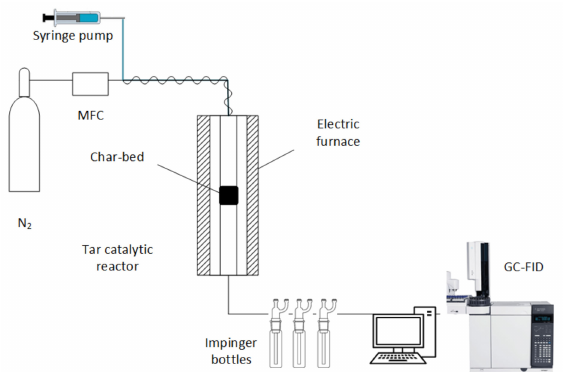
Figure 2. Scheme of the catalytic reactor setup used for testing the adsorption and catalytic activity of